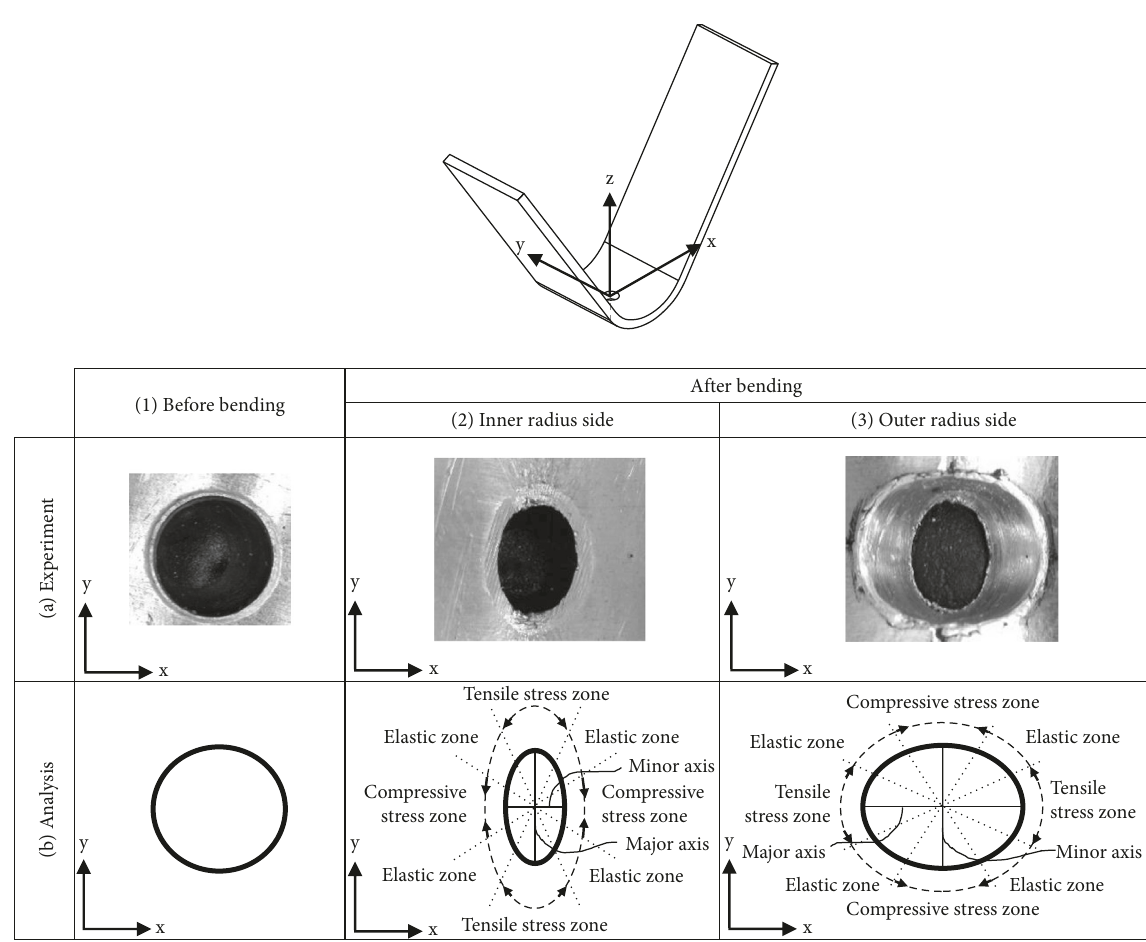
Figure 5: Illustration of plastic deformation and stress analysis on hole in the case of hole located at bend radius zone (hole diameter: 5mm, bend angle: 60 ° ). (a) Experiment. (b)